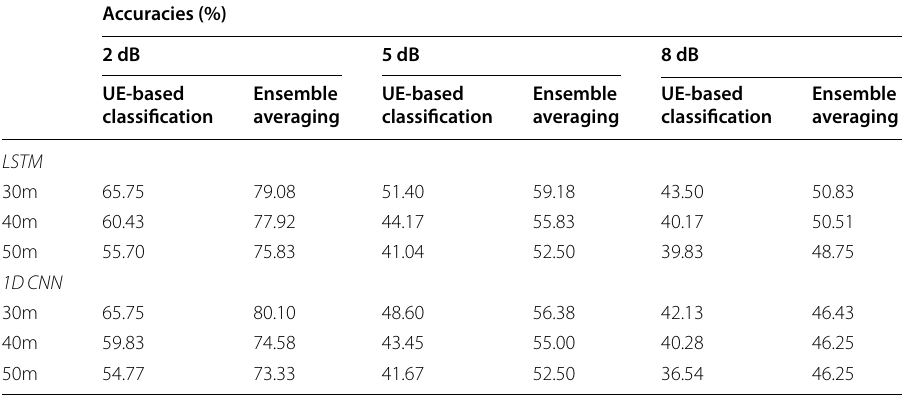
Table 2 Four-category accuracies: UE-based raw classification vs aggregation decision Accuracies